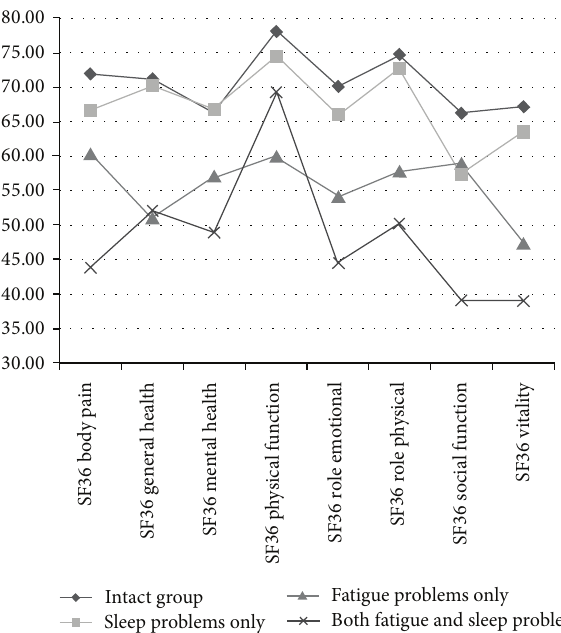
Figure 1: SF36 domain scores for the 4 sleep/fatigue